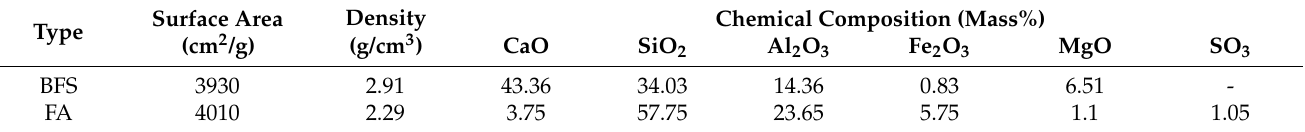
Table 1. Chemical Compositions (wt.%) and Physical Properties of bfs and fa. Surface Type